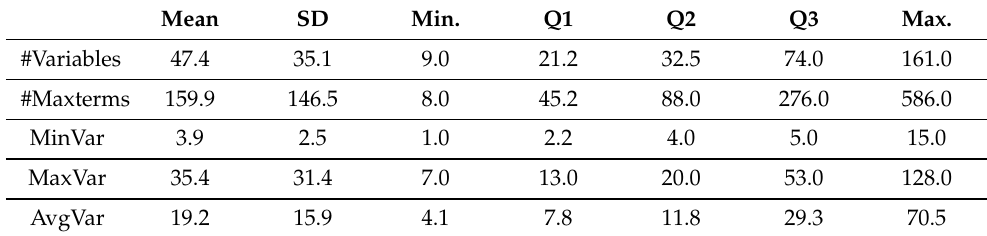
Table 1. Statistics of test